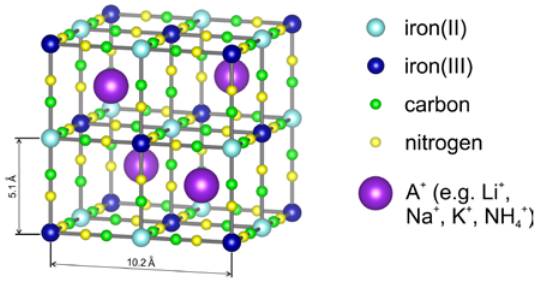
Figure 2. Structure of the defect-free Prussian blue lattice according to the Keggin and Miles model from 1936 with four alkali ions in alternate octants.